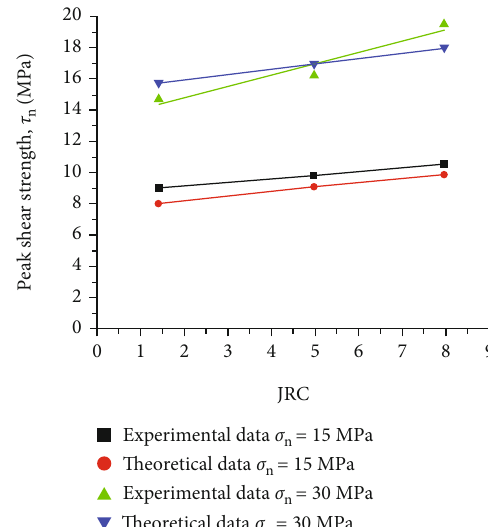
Figure 7: Comparisons of experimental and theoretical peak shear strengths of engraved joints with di ff erent JRC values under direct shear tests at two normal